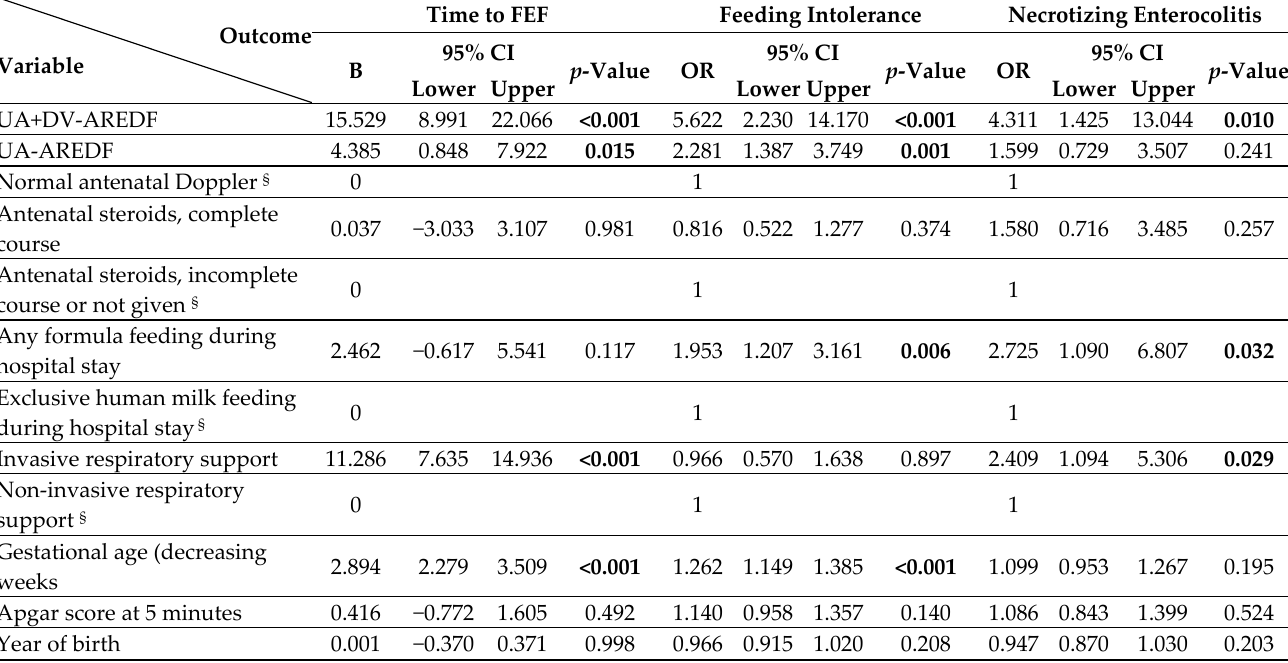
Table 3. Results of the generalized linear models for outcomes that were significantly associated with the severity of antenatal Doppler alterations in the univariate analysis. B indicates the regression coefficients for continuous data outcomes that can be interpreted as in a linear regression model, whereas OR indicates the odds ratio for binary outcomes. When the independent variable is categorical, one group is used as the reference category (§). Significant p -values are highlighted in bold. Abbreviations: CI, confidence interval; FEF: full enteral feeding; UA-AREDF: absent or reversed end diastolic flow in the umbilical artery only; UA+DV-AREDF: absent or reversed end diastolic flow in the umbilical artery and in the ductus venosus.